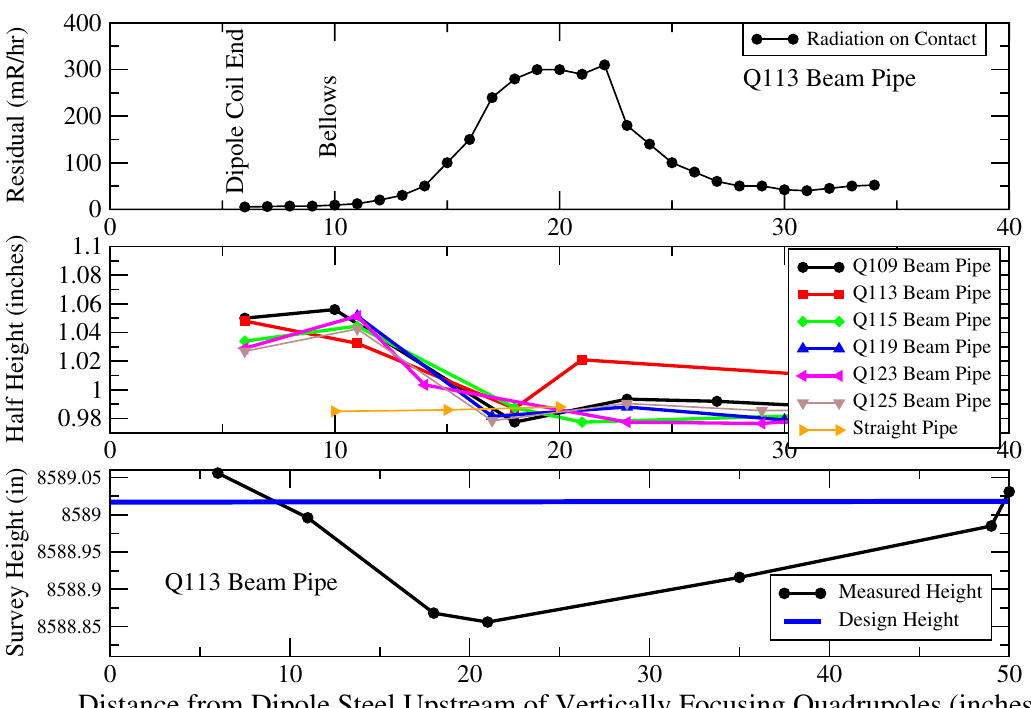
FIG. 11. Geometric distortions of beam pipes permitted beam loss at locations upstream of vertically focusing quadrupoles. The resulting residual radiation distribution on top of beam pipe near Q113 (upper panel); restriction due to beam pipe flexing under vacuum load (center panel) for various locations; and restriction near Q113 from misalignment due to asymmetric stress relieving of insertion-induced beam pipe stress. All locations experienced flexing; many experienced